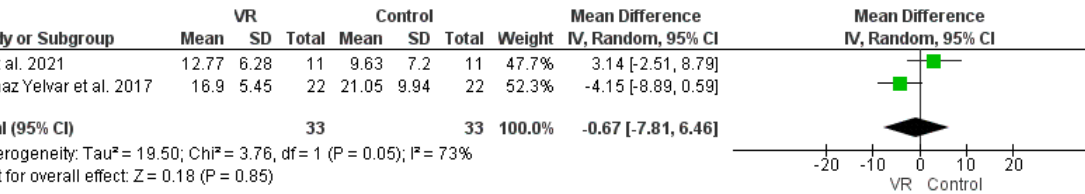
Figure 7. Effect of VR and control intervention on ODI outcome. Green squares represent mean